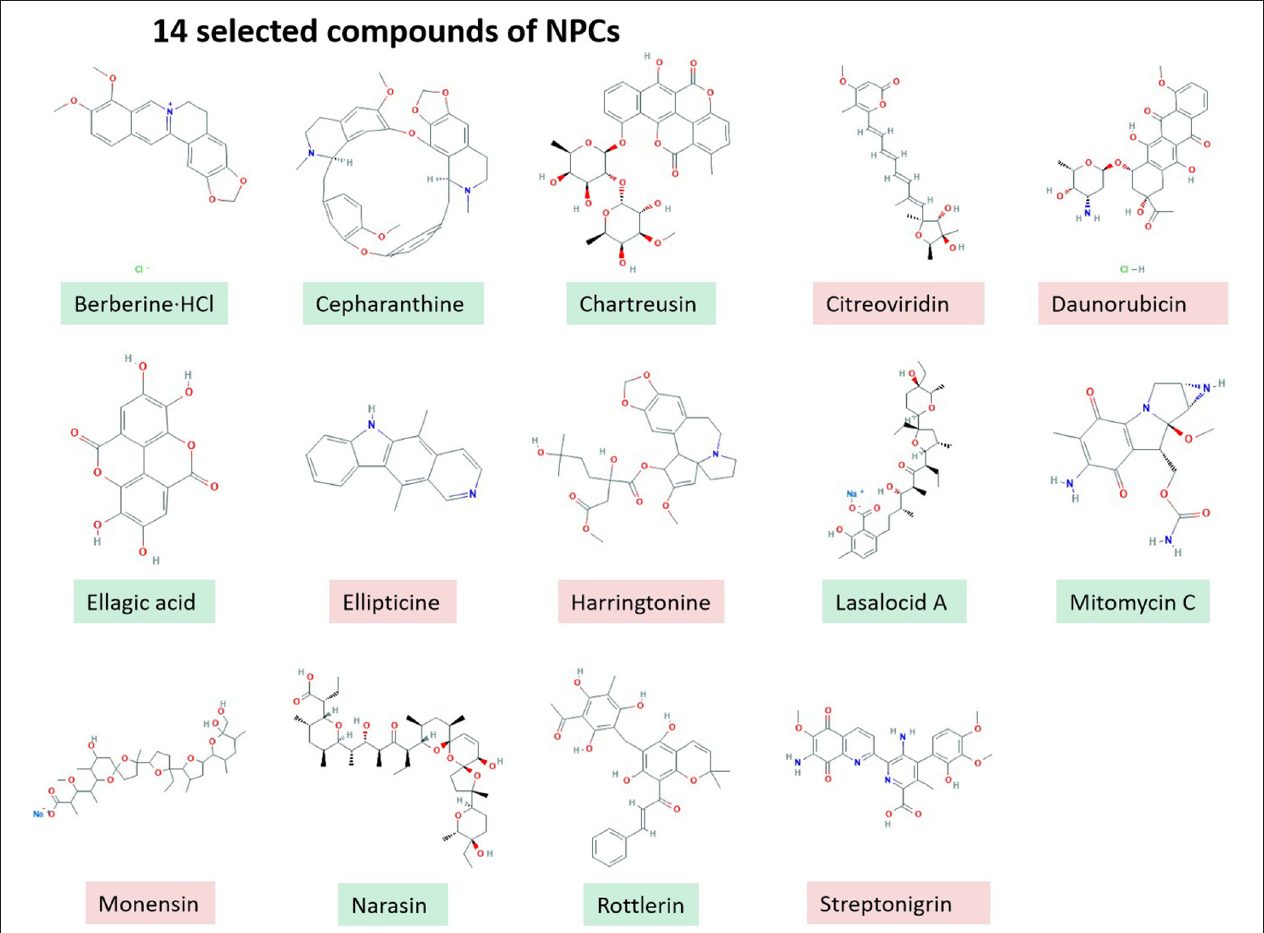
FIGURE 1 | 14 selected compounds of